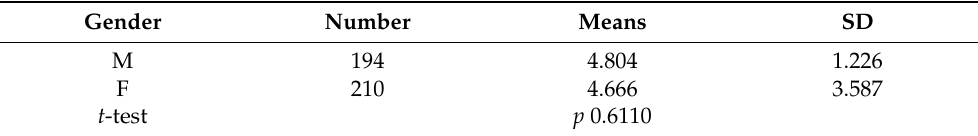
Table 6. Average values and standard deviations for the Corsi’s test score in CVF, with respect to